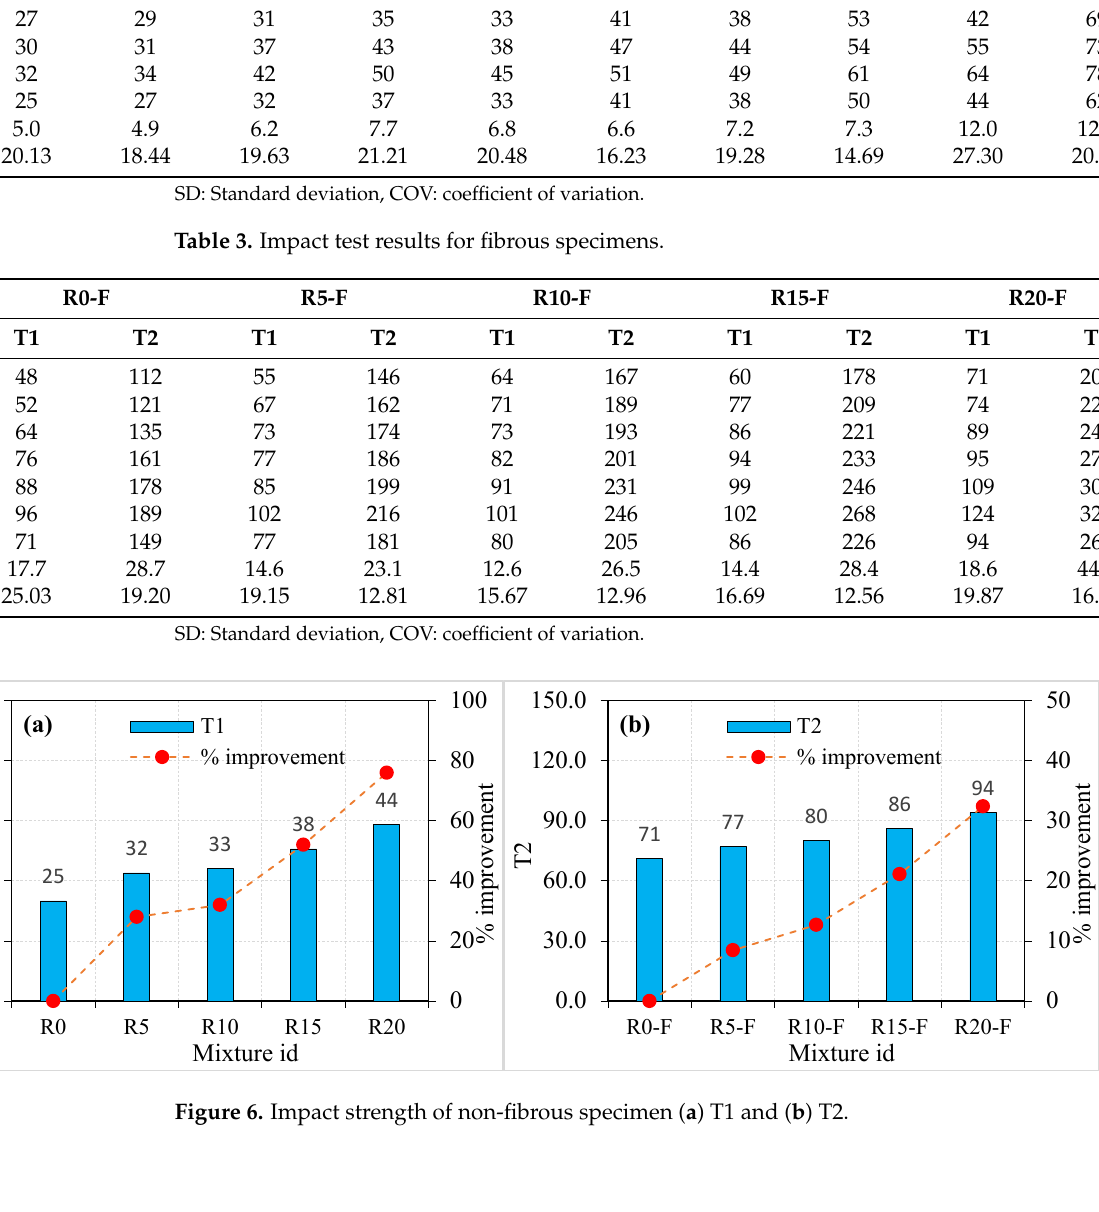
Figure 7. Impact strength of fibrous specimen ( a ) T1 and ( b ) T2. It is obvious from the compressive strength results of the study and in literature [22,23] that crumb rubber decreases the strength of concrete and its modulus of elasticity. In addition to the other reasons discussed in the previous section, this action is mainly attributed to the weak surface bond between the rubber particles and the surrounding cement paste owing to their smooth surfaces. Oppositely, it was recorded in previous studies [54–56] that using crumb rubber has the potential of improving the impact re- sistance, toughness and energy absorption capacity. Al-Tayeb et al. [57] reported that the impact resistance of concrete beams subjected to flexural impacts was enhanced by the partial substitution of sand by crumb rubber. The reported percentage improvements in T1 and T2 for replacement ratios of 5, 10 and 20% were in the ranges of 16 to 35%, 25 to 91% and 50 to 145%, respectively. Khalil et al. [58] reported that percentage increases in T1 and T2 of approximately 80 and 152% were recorded for disk specimens of self-com- pacting concrete with sand-crumb rubber replacement ratios of 10 and 20%, respectively. Abdel Aleem et al. [30] reported that crumb rubber replacement rations of 5, 10, 15 and 20% by sand in self-compacting concrete increased the flexural impact energy of beam specimens by 21, 68, 101 and 129%, respectively, while the percentage developments for cylindrical impact specimens were approximately 9, 14, 33 and 46%, respectively. The re- ported percentage improvement ranges show some agreement level with the results ob- tained in this study. Considering the different rubber particle sizes, different specimen shapes and sizes, different testing boundary conditions and different concrete types tested, it can be generalized that crumb rubber as a replacement of fine or coarse aggregate can noticeably enhance the impact resistance of concrete. Crumb rubber as a low-stiffness material when added to a concrete mixture decreases its stiffness and elastic energy, which negatively affects the mixture’s strength and modulus of elasticity. On the other hand, the high plastic energy capacity and superior ductility of crumb rubber aggregate